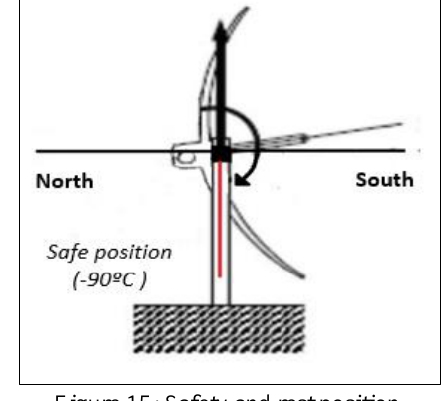
Figure 15: Safety and rest position.